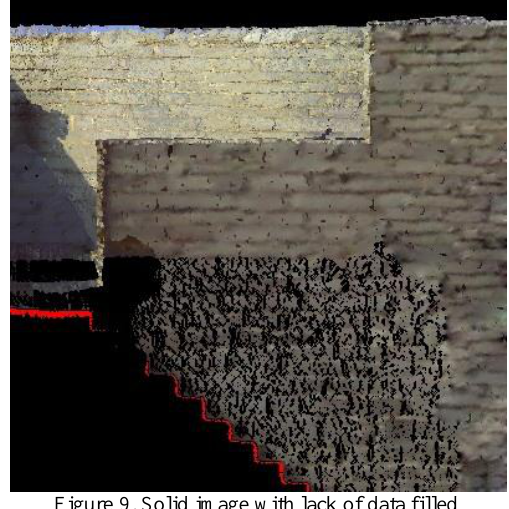
Figure 9. Solid image with lack of data filled